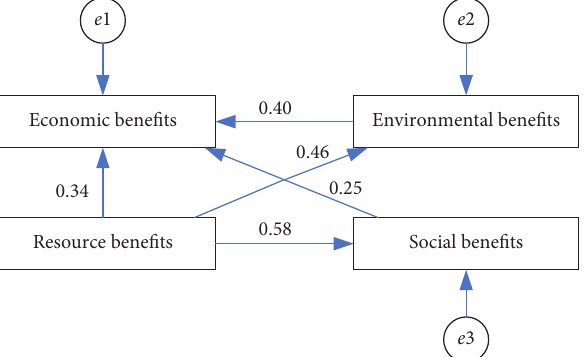
Figure 3: Causal relationship model between